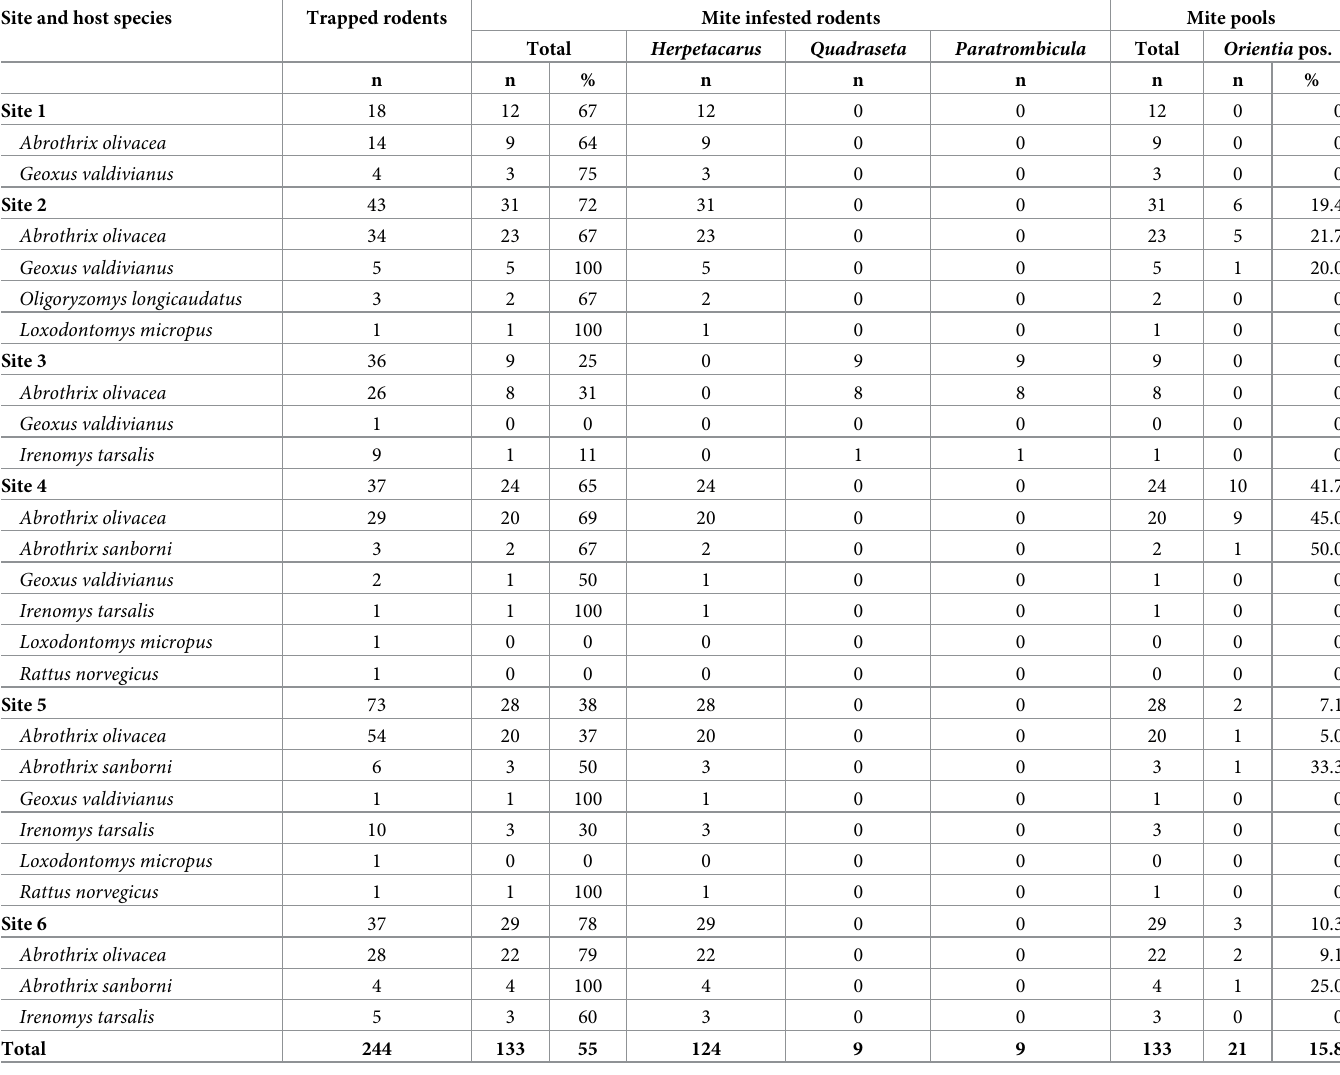
Table 2. Prevalence of infestation with trombiculid mites and infection of mite pools with Orientia species per site and rodent species. Site and host species